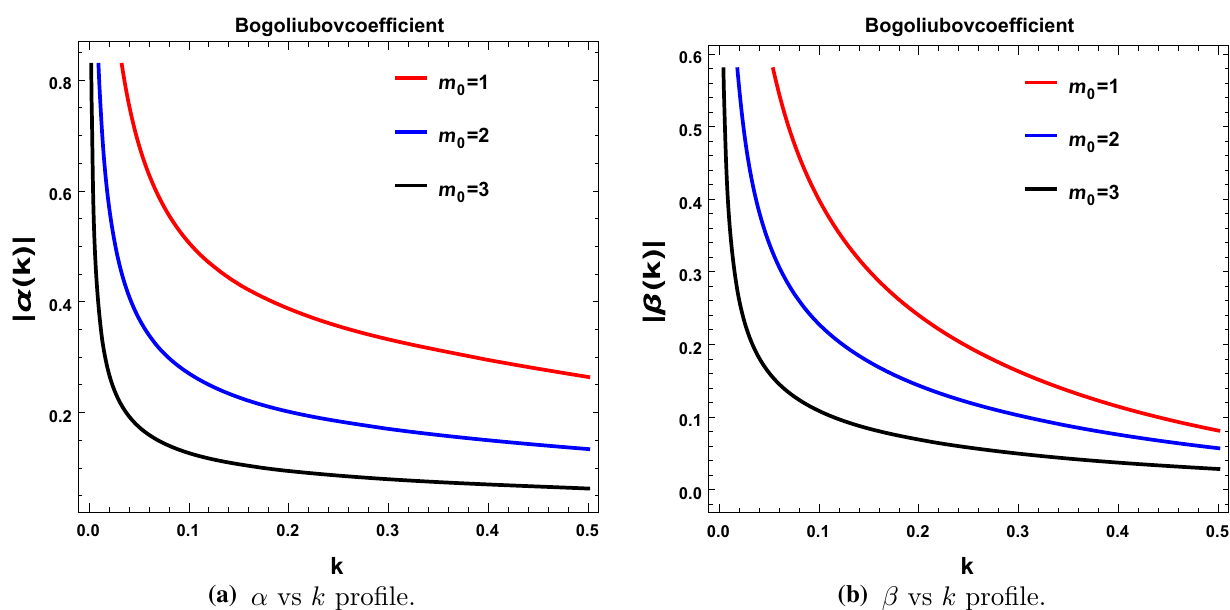
(b) β vs k profile.